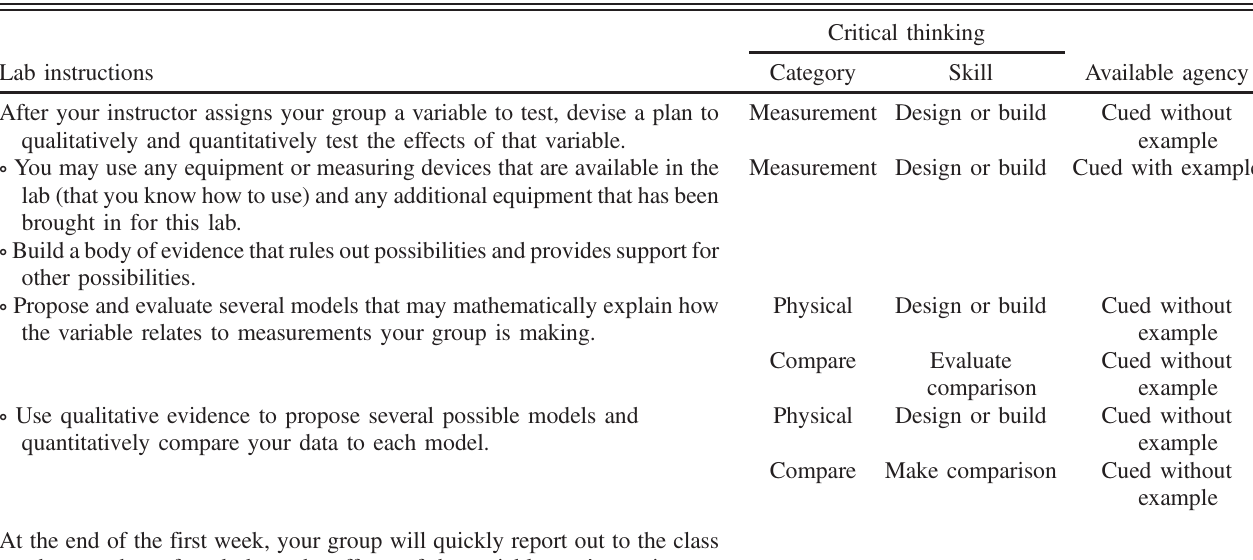
TABLE III. Application of coding scheme for an excerpt from the Electricity! Magnetism! Fun! activity in semester 2.